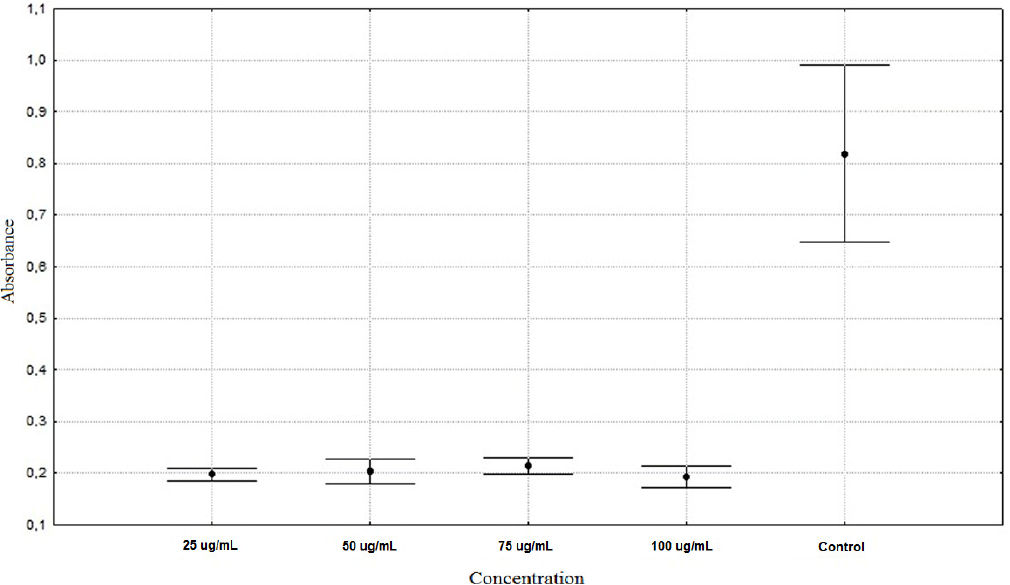
Figure 1. Antiproliferation activity of Allium schoenoprasum phenolic compounds on HaCaT cells (average ± SD).